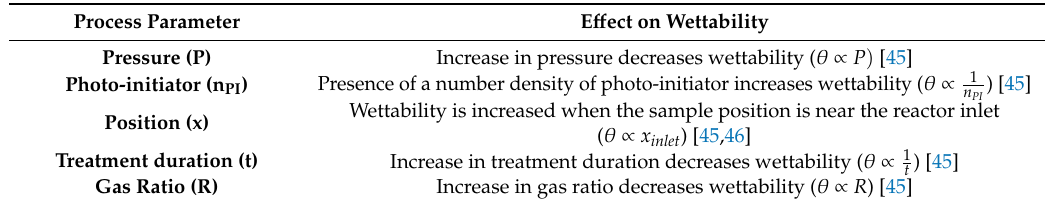
Table 1. Photo-initiated chemical vapor deposition (PICVD) processing parameters e ff ects on surface wettability. Process Parameter